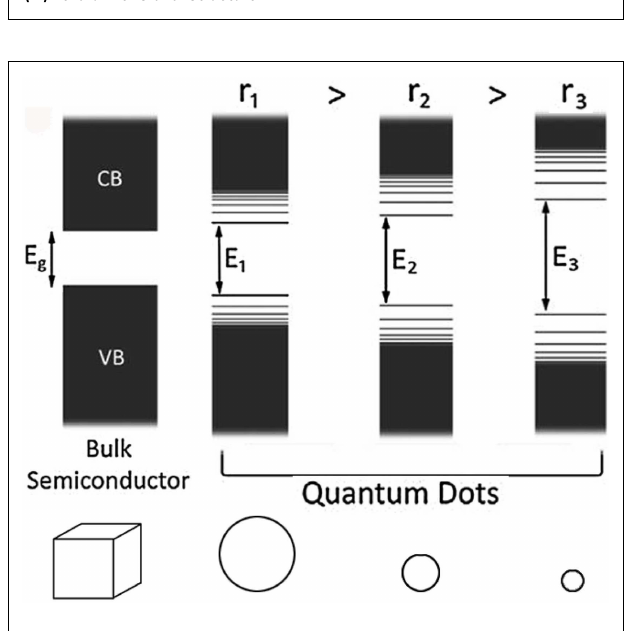
FIGURE 2 | Influence from the size of materials to its band gap .